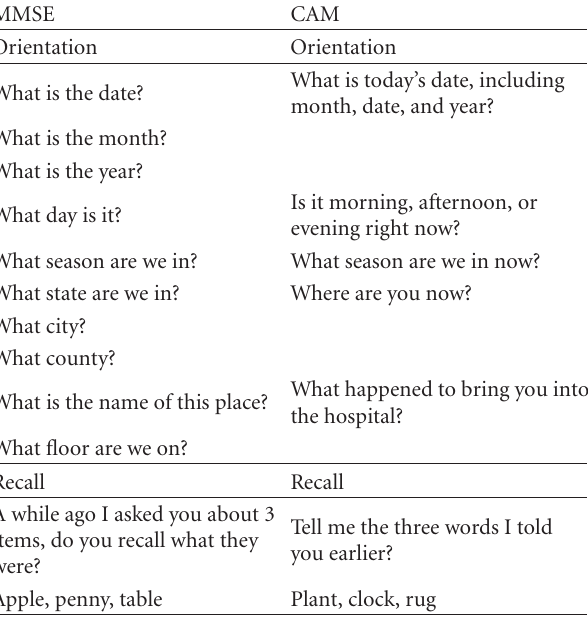
Table 1: Specific items used for sub